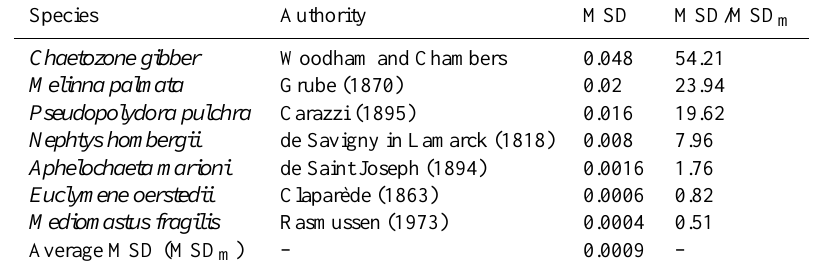
Table 6. Mean square drift (MSD) for the most abundant species of polychaetes in RM station. The third column is the normalised coefficient.